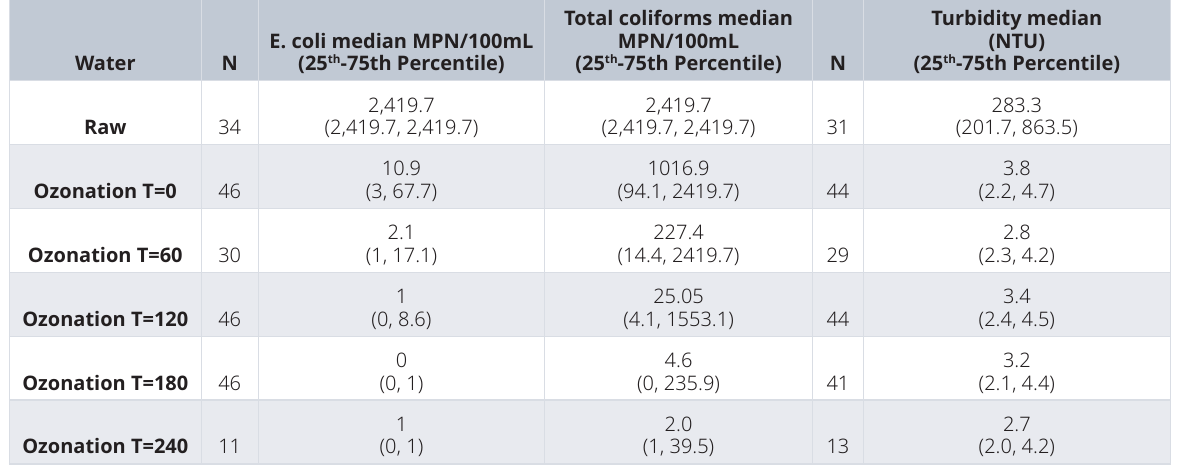
Table 1. Water quality at baseline (raw water), after filtration and flocculation (ozonation T=0), and during ozonation. MPN, most probable number; NTU, nephelometric turbidity units; T, duration of ozonation, in minutes.